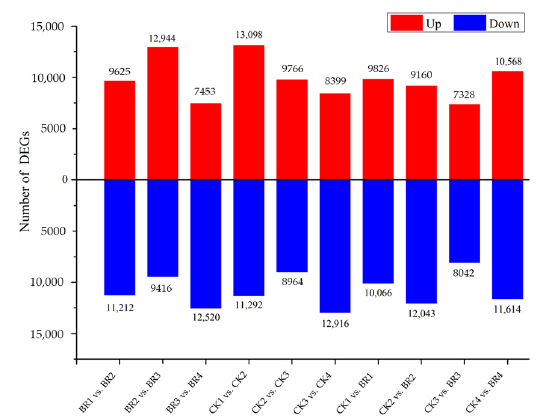
Figure 4. Number of differentially expressed genes. The red columns represent the up-regulated genes. The blue columns represent the down-regulated genes.